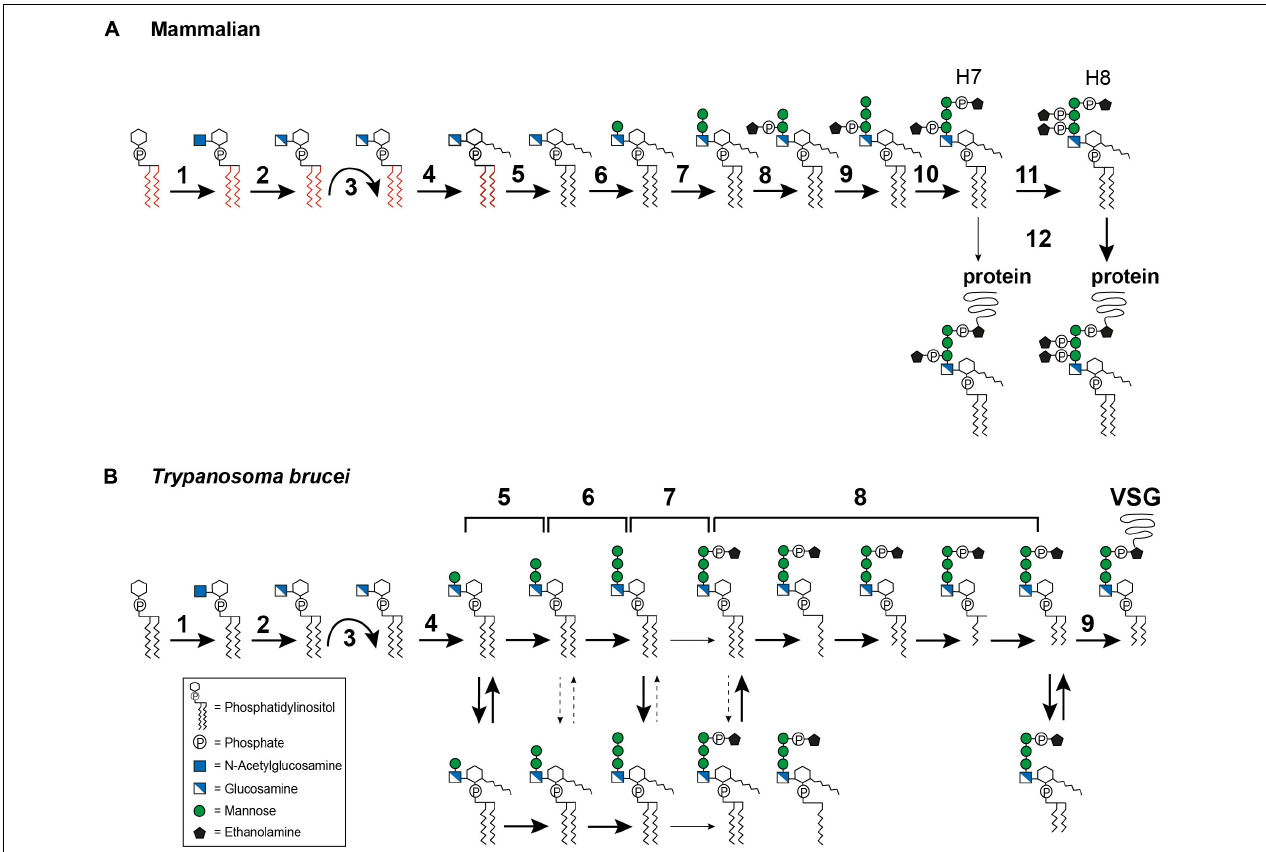
FIGURE 3 | Glycosylphosphatidylinositol biosynthesis pathway up to the point of protein attachment. (A) Mammalian GPI biosynthesis steps at and within the endoplasmic reticulum (ER). The reaction steps are numbered and are described in detail in the text: (1) transfer of N -acetylglucosamine (GlcNAc) to phosphatidylinositol (PI), (2) deacylation of GlcNAc-PI, (3) flipping of GlcN-PI into the ER lumen, (4) inositol acylation, (5) lipid remodeling, visualized by the color change from red to black, (6–7) addition of mannose, (8) addition of ethanolamine phosphate (EtN-P), (9) addition of mannose, (10) addition of EtN-P, (11) addition of EtN-P, (12) attachment of the GPI anchor to the protein. The occasionally observed addition of a fourth mannose is not depicted. (B) GPI biosynthesis steps at and within the ER in Trypanosoma brucei . The reaction steps are numbered and are described in detail in the text: (1) transfer of N -acetylglucosamine (GlcNAc) to phosphatidylinositol (PI), (2) deacylation of GlcNAc-PI, (3) flipping of GlcN-PI into the ER lumen, (4–6) addition of mannose, (7) addition of EtN-P, (8) lipid remodeling, (9) attachment of the GPI anchor to the protein. The broad solid arrows indicate reactions for which direct evidence exists. The dashed arrows indicate conversions that may exist. The light solid arrows indicate reactions that are not frequently observed. The curved arrows indicate the flipping reaction into the ER